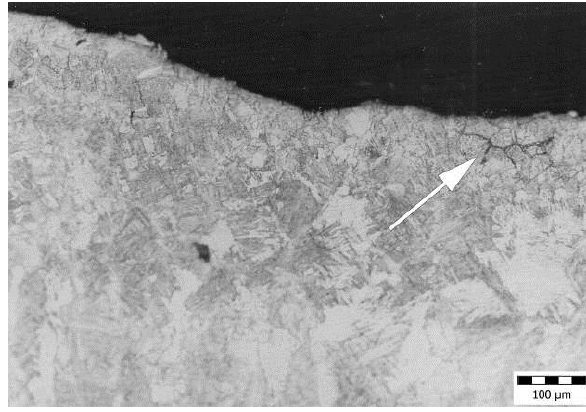
Figure 8: Cracks in the surface area of sample C.